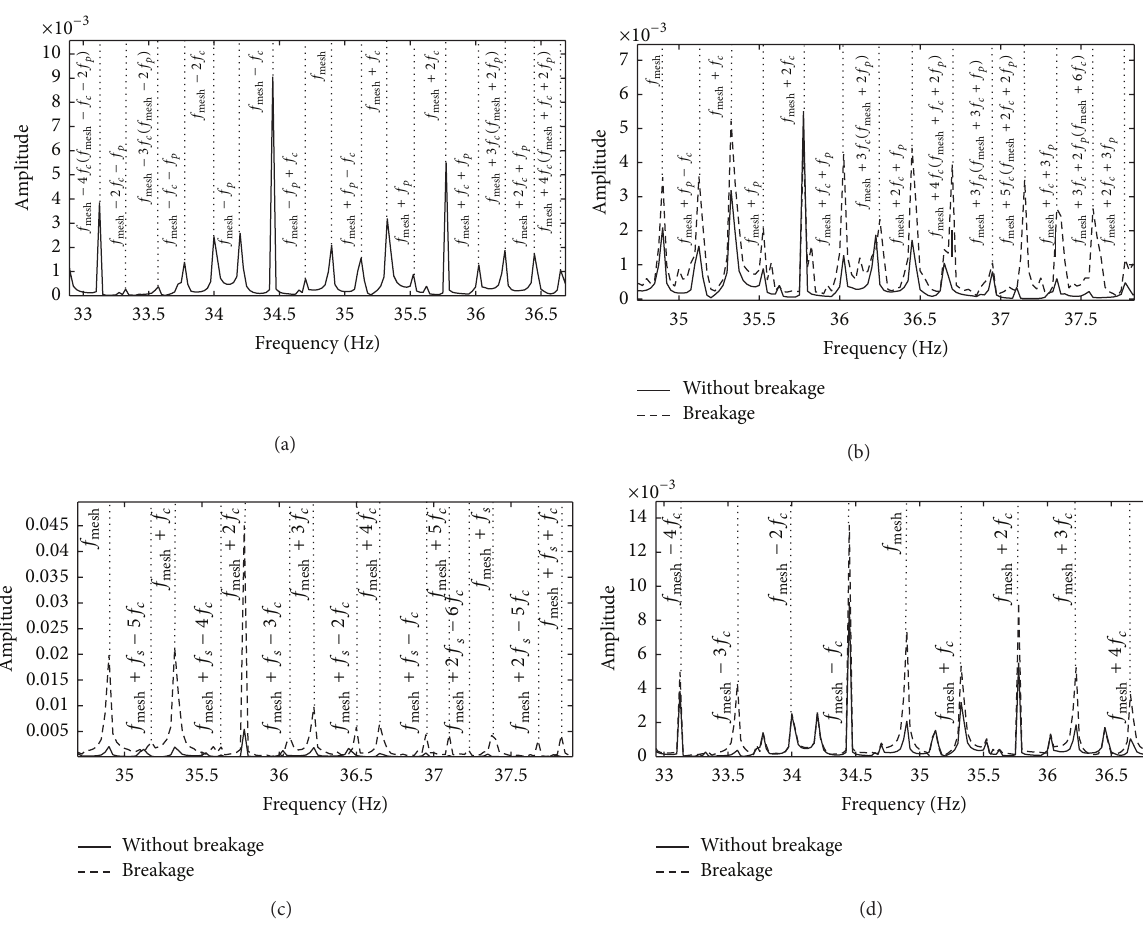
Figure 6: The spectrum of the system with and without tooth breakages (with errors): (a) without breakage, (b) planet gear with and without ), (c) sun gear with and without tooth breakages (the right side of 𝑓 tooth breakages (the right side of 𝑓 mesh tooth breakages.